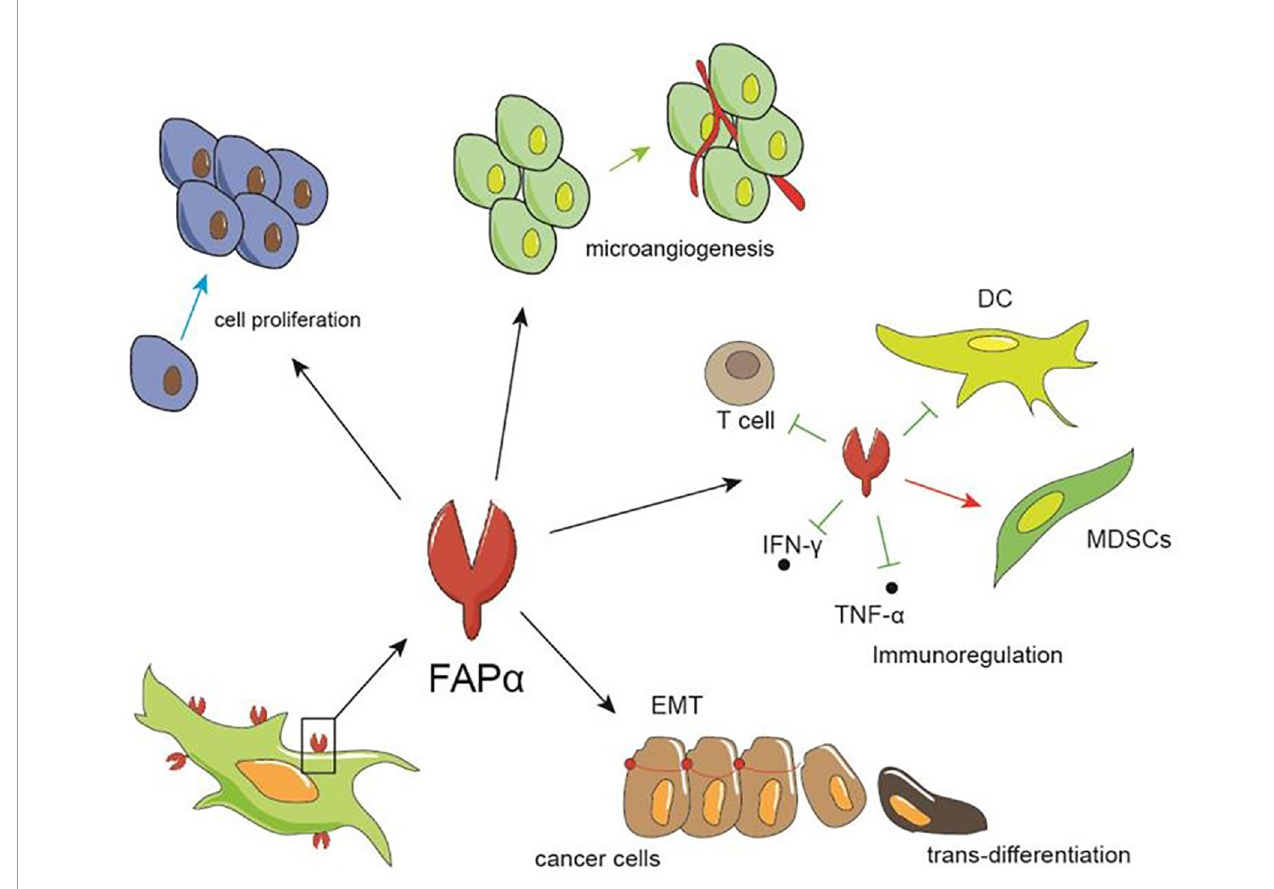
FIGURE 2 | The role of FAP in tumors. FAP can promote tumor growth by facilitating the proliferation and invasion of tumor cells, promoting the formation of microvessels, and regulating immunity, such as inhibiting the differentiation and maturation of dendritic and T cells, thereby increasing the proportion of myeloid suppressor cell, and up-regulating IFN- g and TNF- a